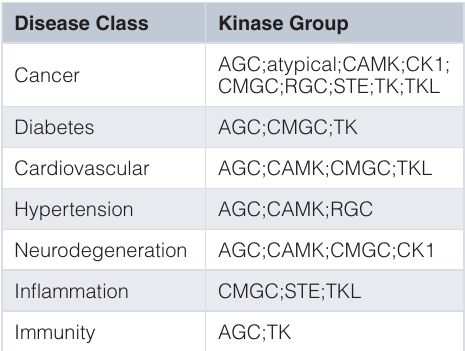
Table 3. Kinase-disease association in top therapeutic